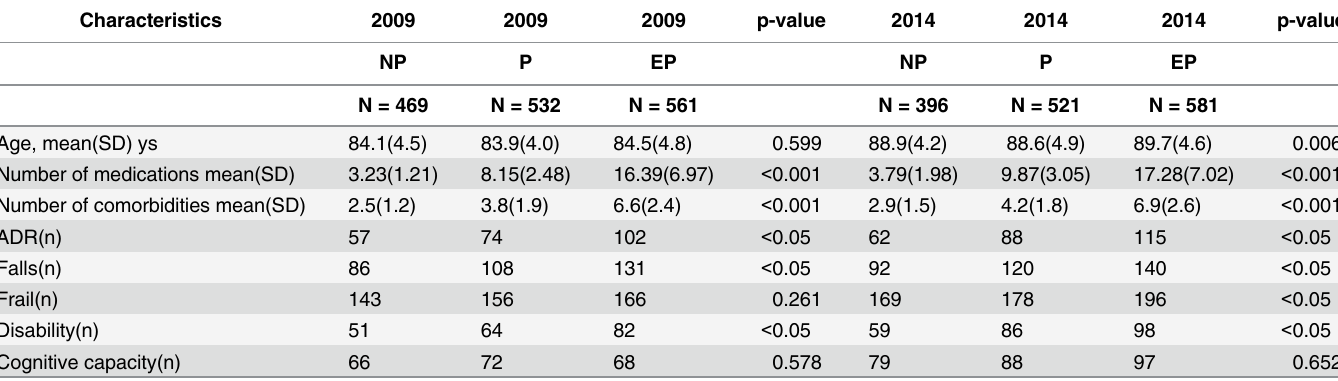
Table 2. Changes (%) in functional ability (IADL test) and cognitive capacity (MMSE test) among survivors from 2009 to 2014. Characteristics